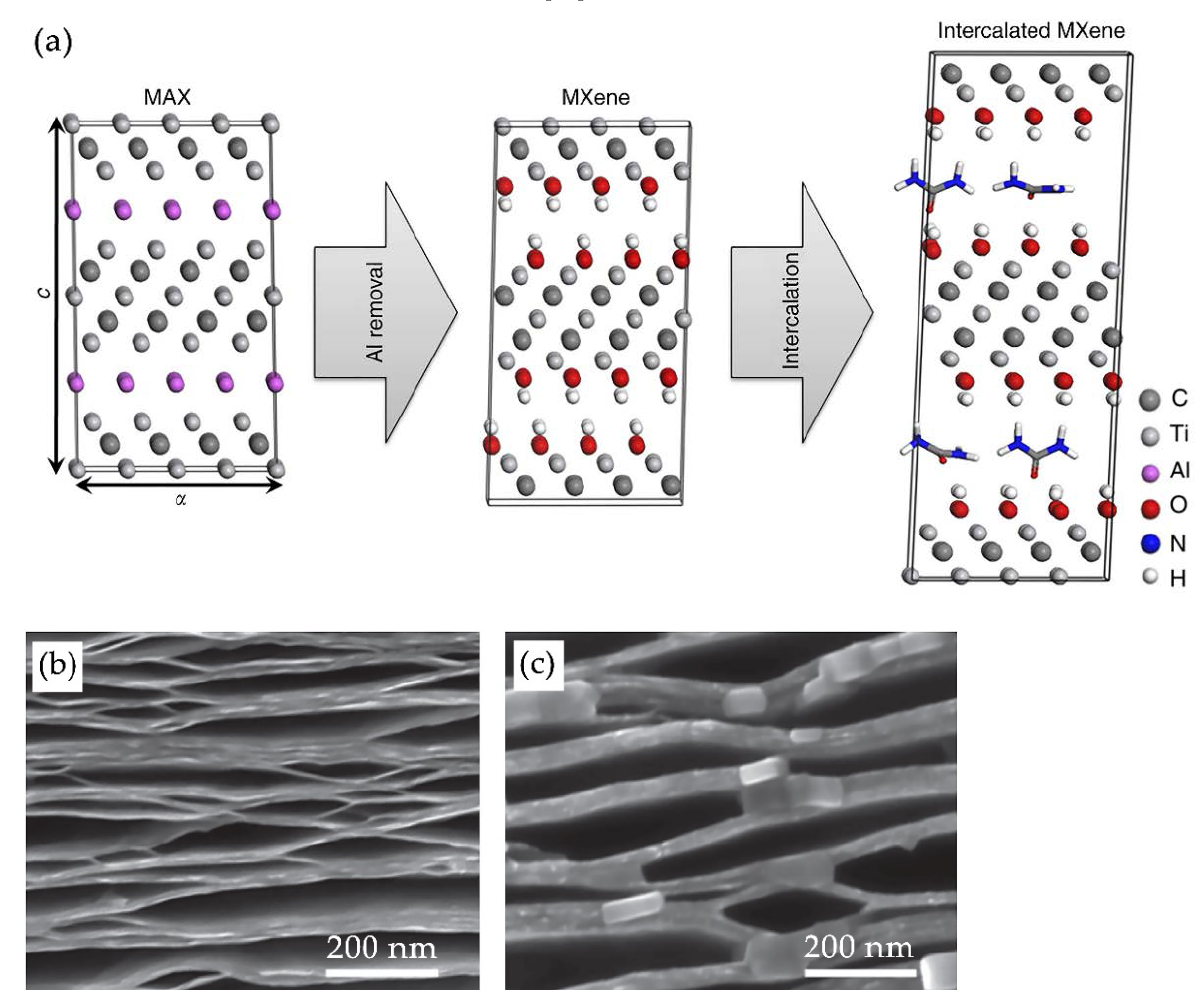
Figure 18. ( a ) Scheme of the synthesis of Ti 3 C 2 T x MXene with selective etching of the MAX phase and subsequent intercalation (for example, urea is shown as an intercalant). SEM micrographs of Ti 3 C 2 T x ( b ) before and ( c ) after intercalation with hydrazine monohydrate dissolved in N,N-dimethylformamide for 24 h at 80 ◦ C. Reprinted with permission from [9] 2013 Springer Nature.